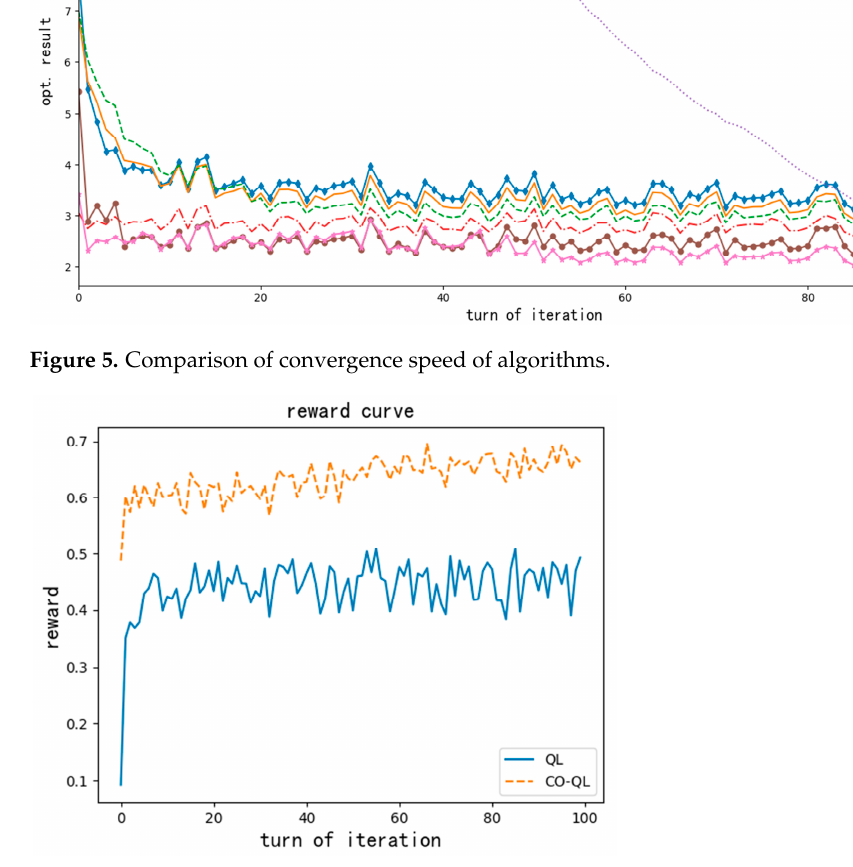
Figure 6. Reward functions of the two QL algorithms.